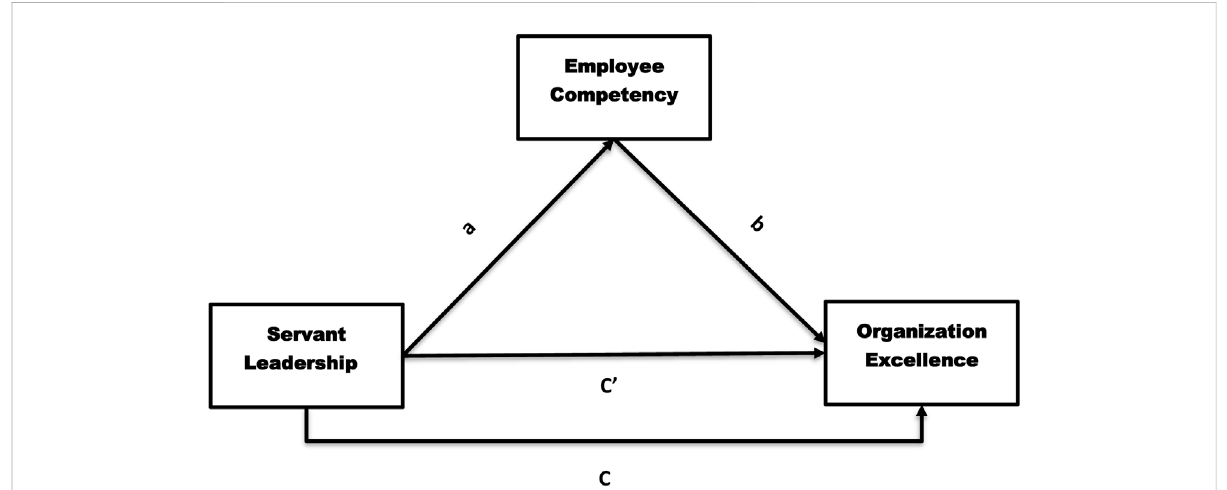
FIGURE 1 Predictive conceptual model showing the path directions for mediation, where servant leadership (X) = the independent variable, organization performance (Y) = the dependent variable, employee competency (M) = the mediating variable, a*b = the indirect effect of the mediator on Y, and C ’ = the indirect direct effect of X on Y with the effect of the mediator, and C = direct effect of X on Y without a